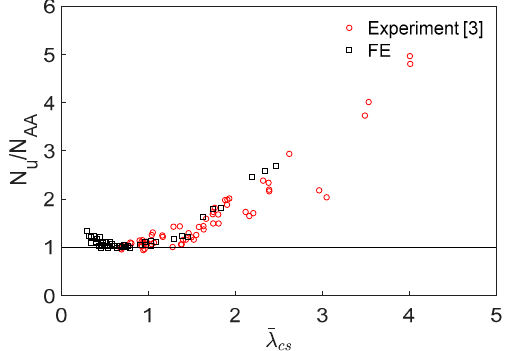
Figure 11. Assessment of AA design strength predictions.